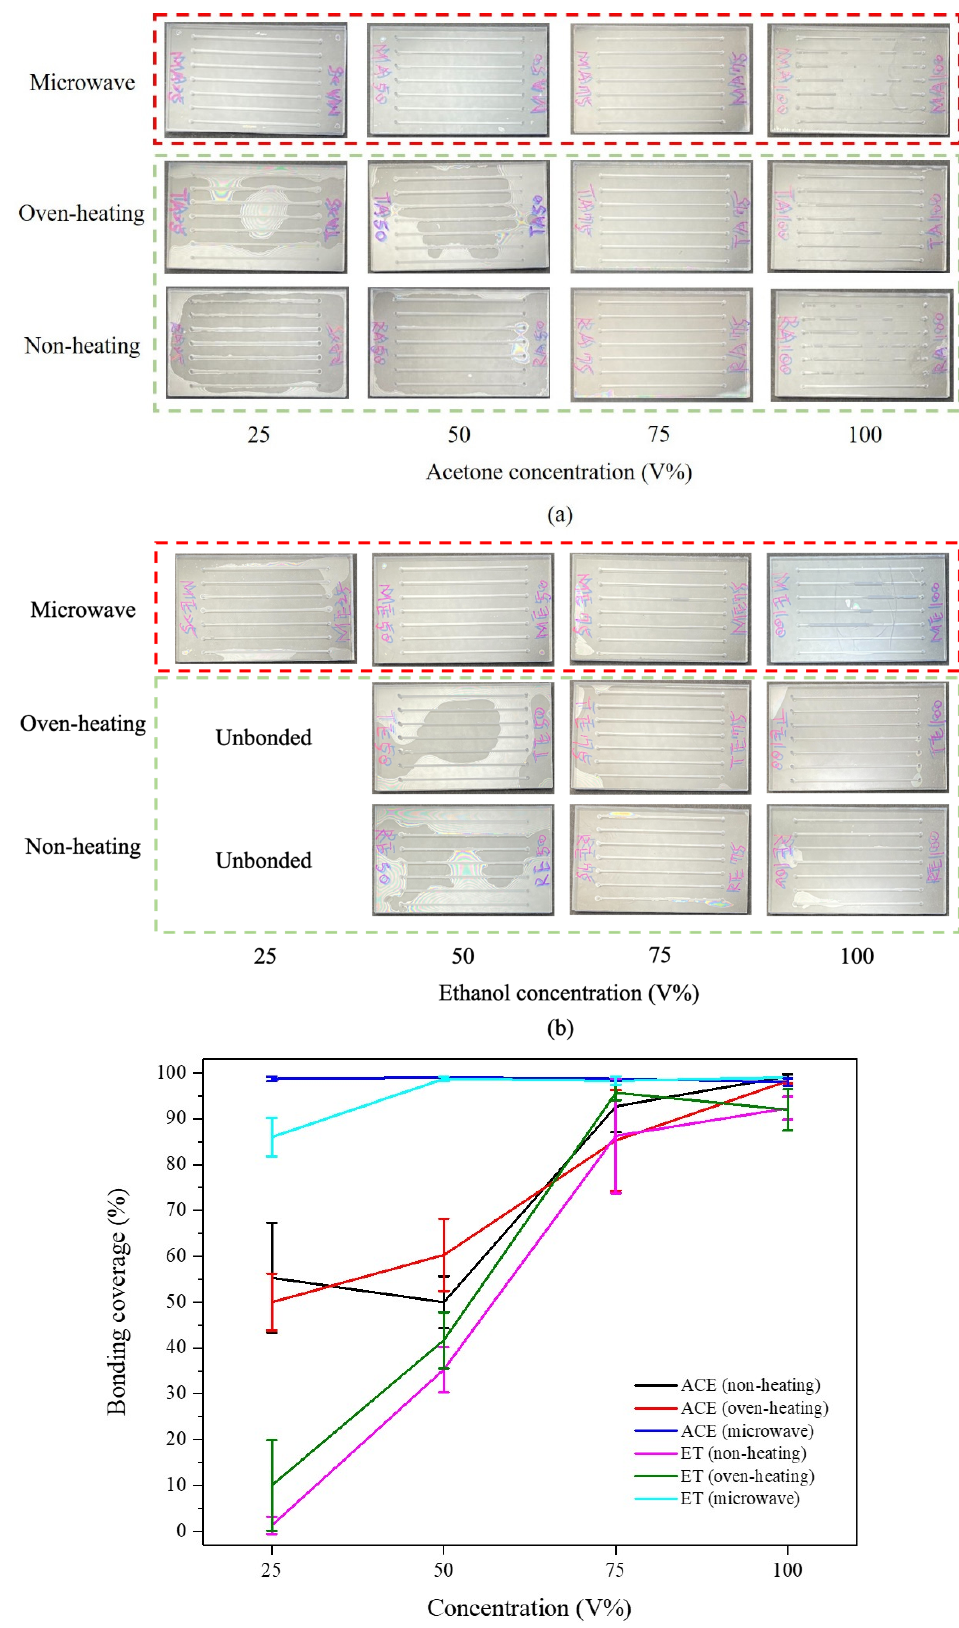
Figure 6. Bonding coverage image of PMMA microchannels with different annealing methods